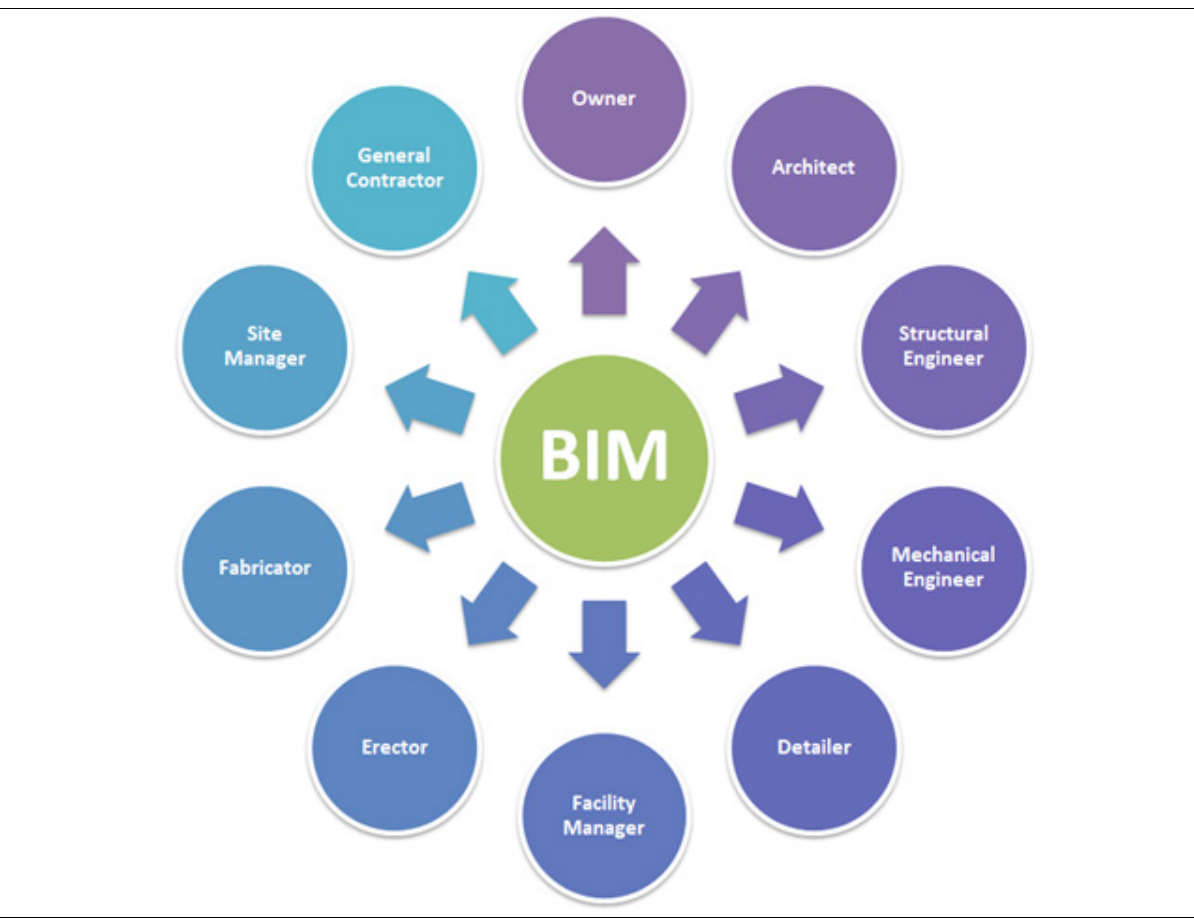
Figure 1: Smart contracts using blockchain